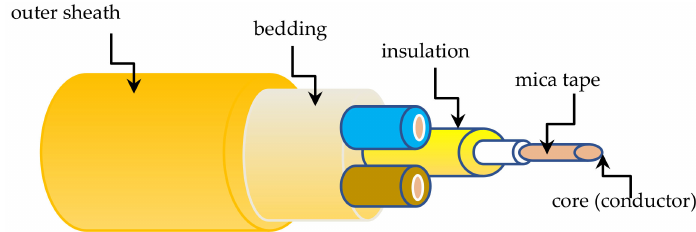
Figure 2. Schematic of the 3-conductor cable sample.